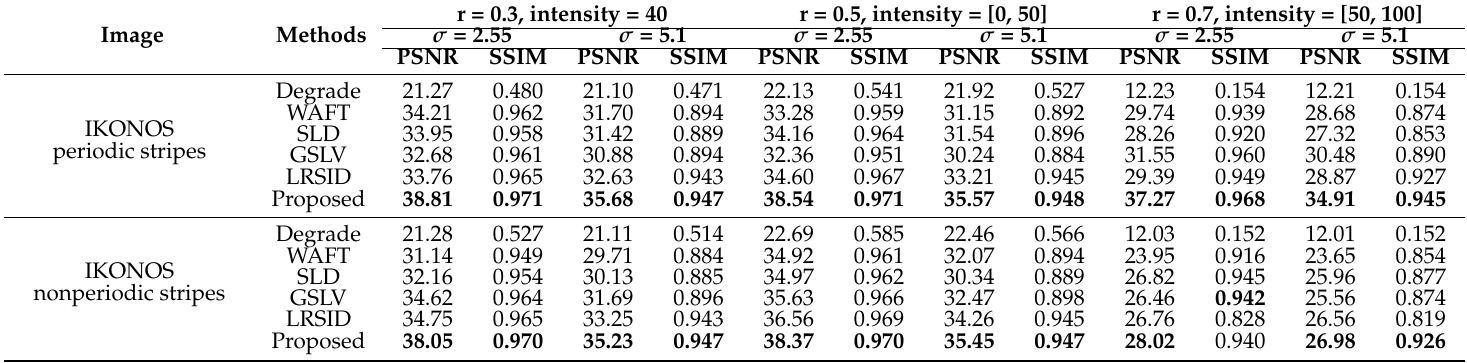
Table 3. PSNR (dB) and SSIM results of the test methods for different stripes with Gaussian mixed noise